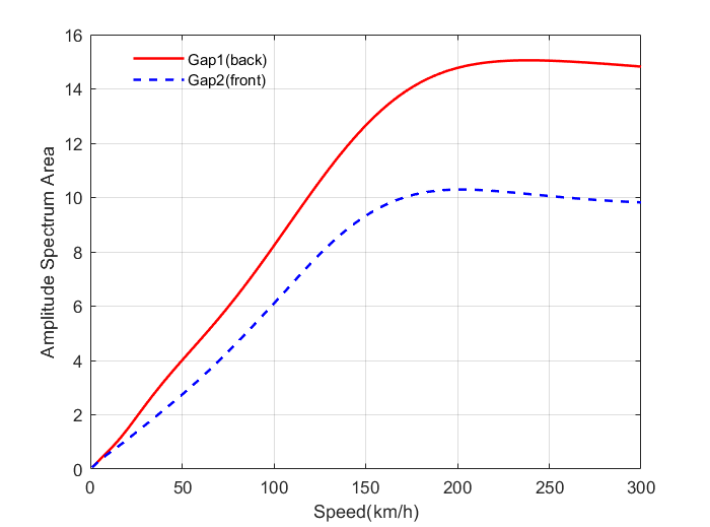
Figure 3. Amplitude spectrum area of levitation gaps vs. vehicle